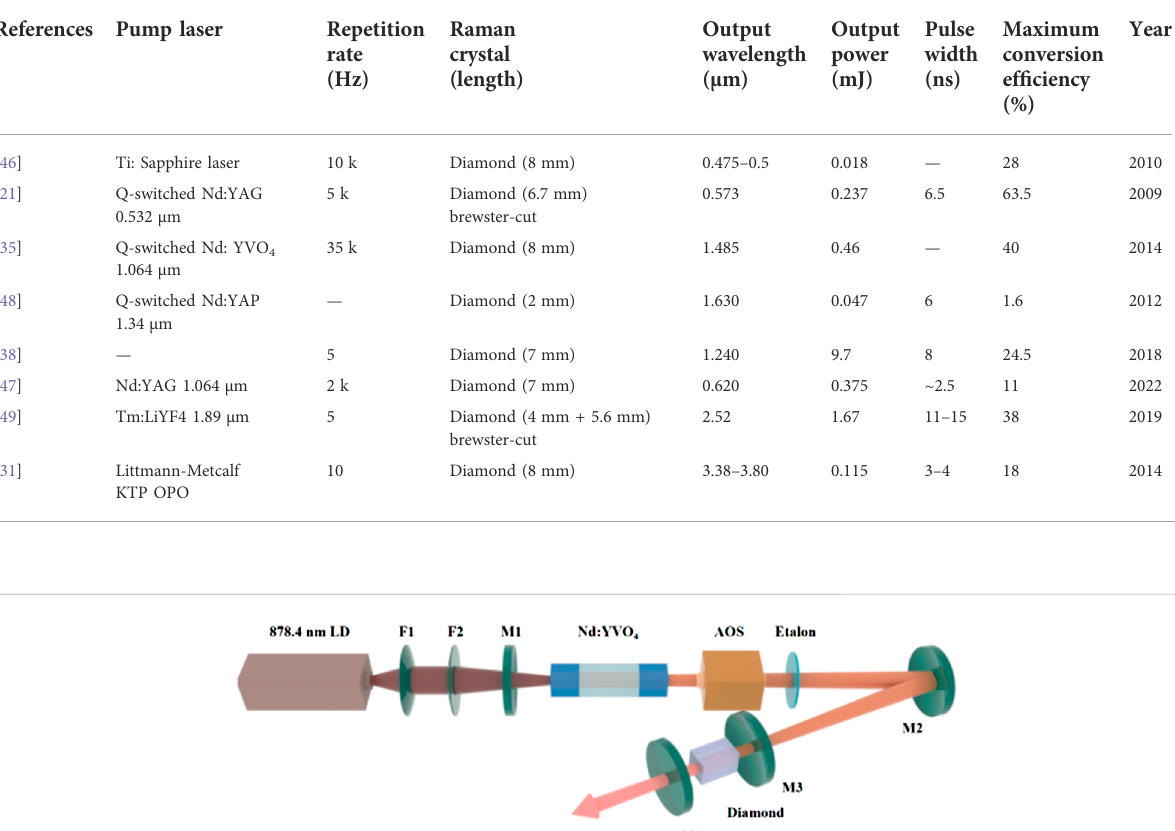
TABLE 3 Summary of DRLs for wavelength expansion.